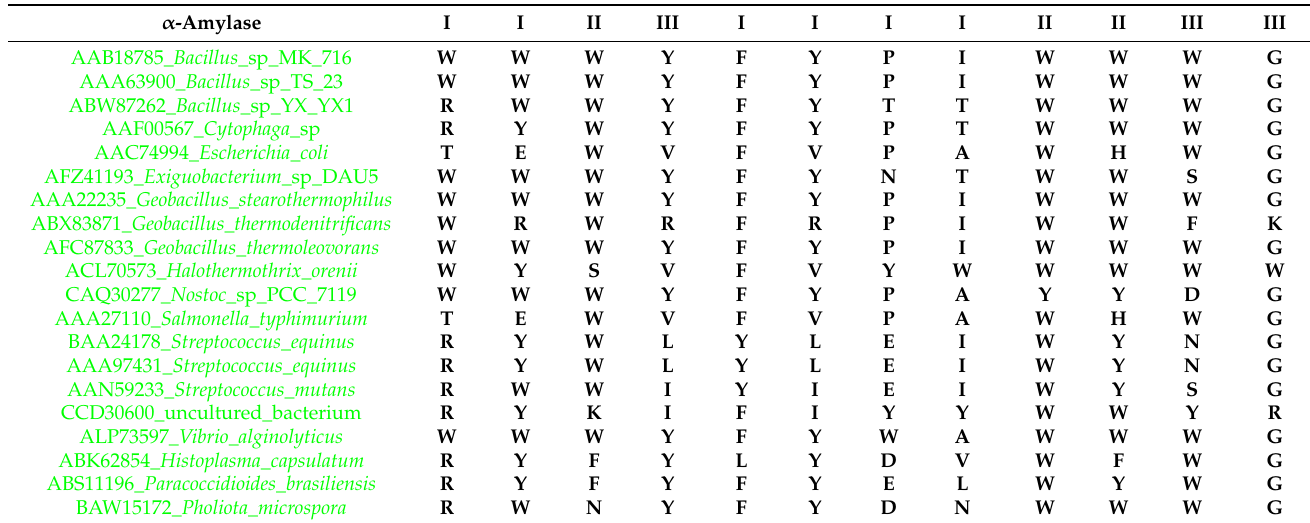
a The potential SBSs in α -amylases from the subfamily GH13_5 have been analysed according to SBSs observed in the three-dimensional structures of the counterpart α -amylases from: (i) Bacillus halmapalus ([50]; PDB code: 2GJP)—SBS-I: W439 and W469; SBS-II: W347; and SBS-III: Y363; (ii) Bacillus licheniformis ([51]; PDB code: 6TOZ)—SBS-I: F257 and Y368; and (iii) Halothermothrix orenii ([52]; PDB code: 3BC9)—SBS-I: Y484 (Y460) and W512 (W488); SBS-II: W284 (W260) and W311 (W287); and SBS-III: W330 (W306) and W334 (W310)—the numbering in parentheses applies if the N-terminal signal peptide is removed; which all are highlighted by green-colour inversion. The individual α -amylases are presented by their GenBank accession Nos. and binomial name of the producing organism. The aromatic residues corresponding with the those forming the real SBSs are highlighted by black